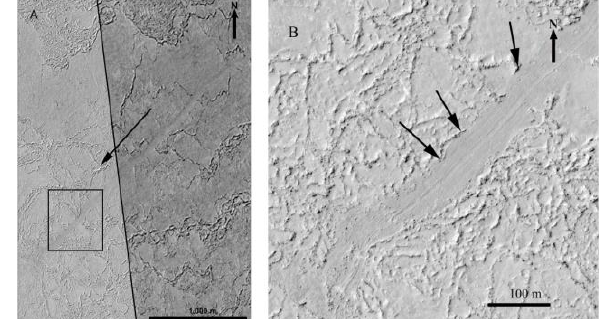
Figure 8. The pre-existing ridges exemplified by the arrows were destroyed by the track of the late flow. The image (A) is a mosaic of subset of HiRISE image ESP_018036_1880_RED.jp2 (left to the line) and CTX of B10_013368_1876_XN_07N210W.jp2 (right to the line). The arrow in (A) indicates the direction of motion of the trace, while the arrows in (B) indicate the previous polygons which were destroyed by the track.